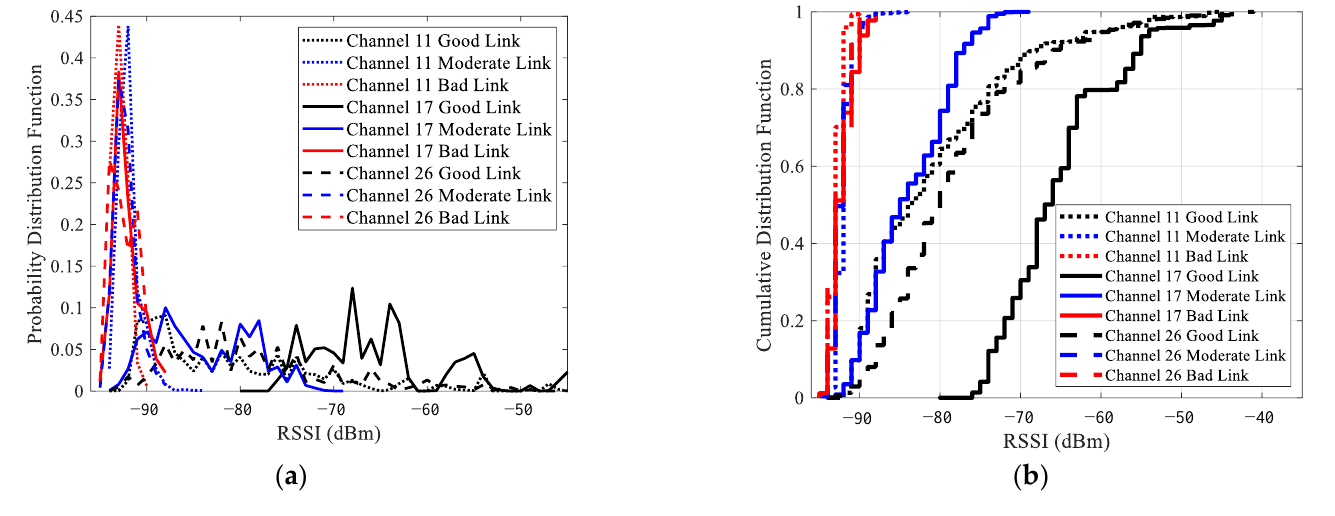
Figure 4. The distributions of RSSI for good links, moderate links, and bad links under the interference-free channel 26, the low interference channel 11, and the high interference channel 17: ( a ) PDF; ( b ) CDF.